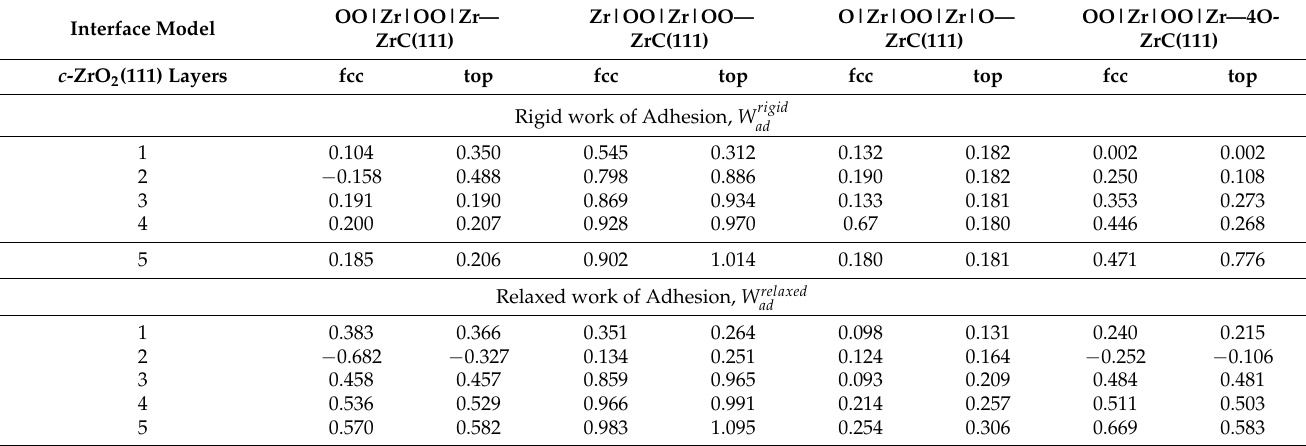
Table 3. Rigid, W rigid and relaxed, W relaxed work of adhesion for different interface models using ad ad different numbers of c -ZrO 2 (111) layers at both fcc and on-top adhesion sites at the interface